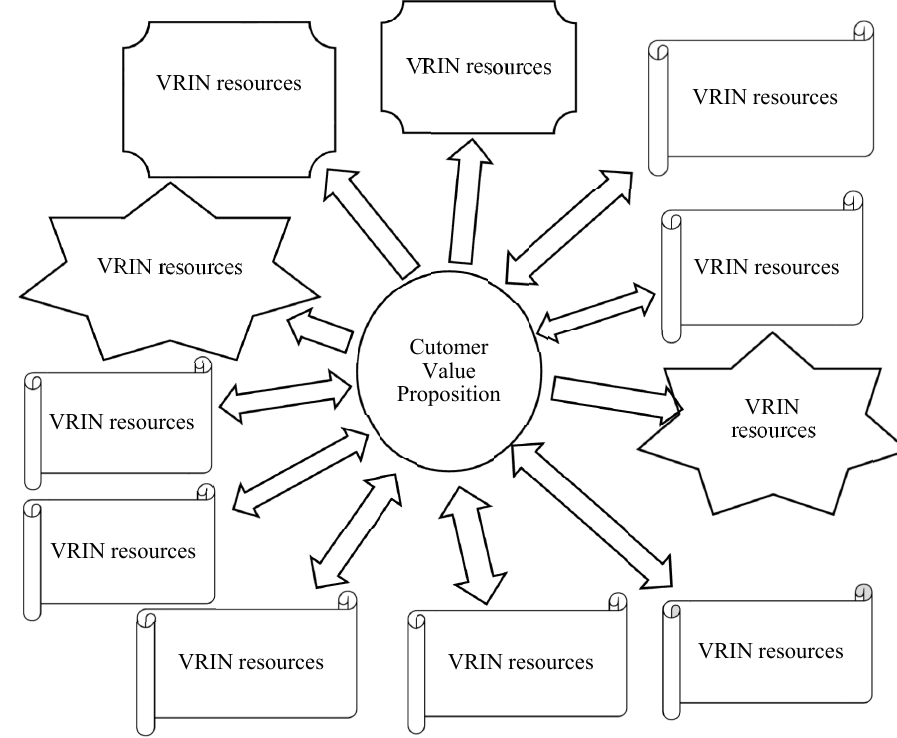
Figure 1. Organizational eco-map. Source: developed by the author.